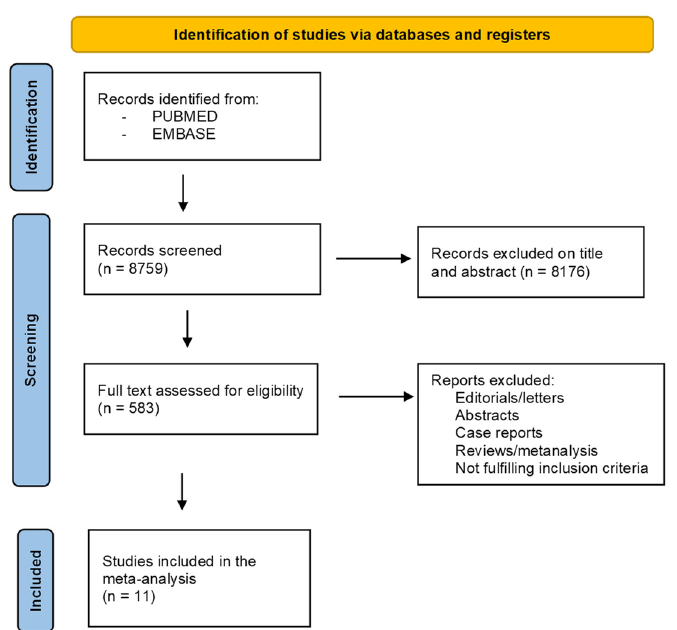
Figure 1. Study selection process (PRISMA flow diagram).